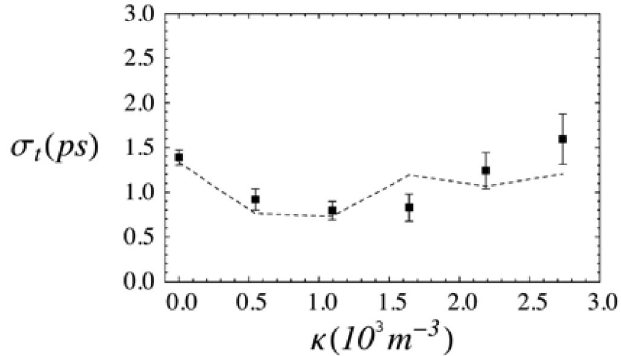
FIG. 6. CTR autocorrelator measurements of electron bunch length a as a function of sextupole field strength, with super- imposed theoretical result (dashed line) obtained from PARMELA/ ELEGANT simulation combined with an autocorrelation algo-